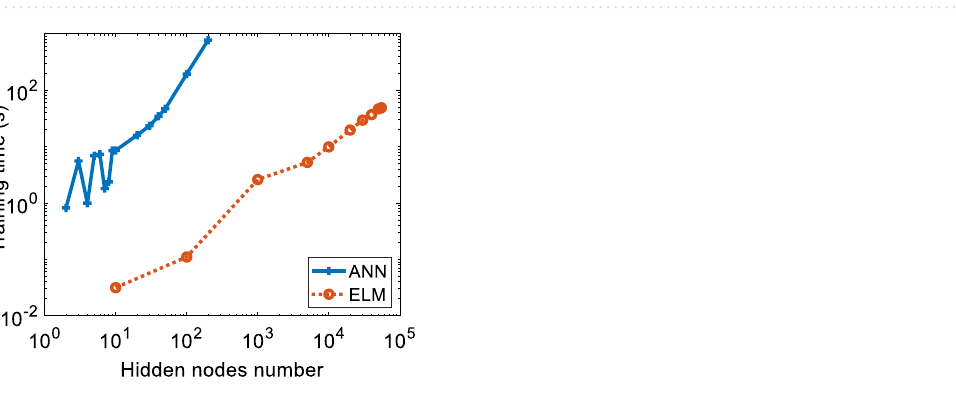
Figure 9. The boxplot of standard error for ANN and ELM model for three data set at the isotropic and anisotropic distributions.